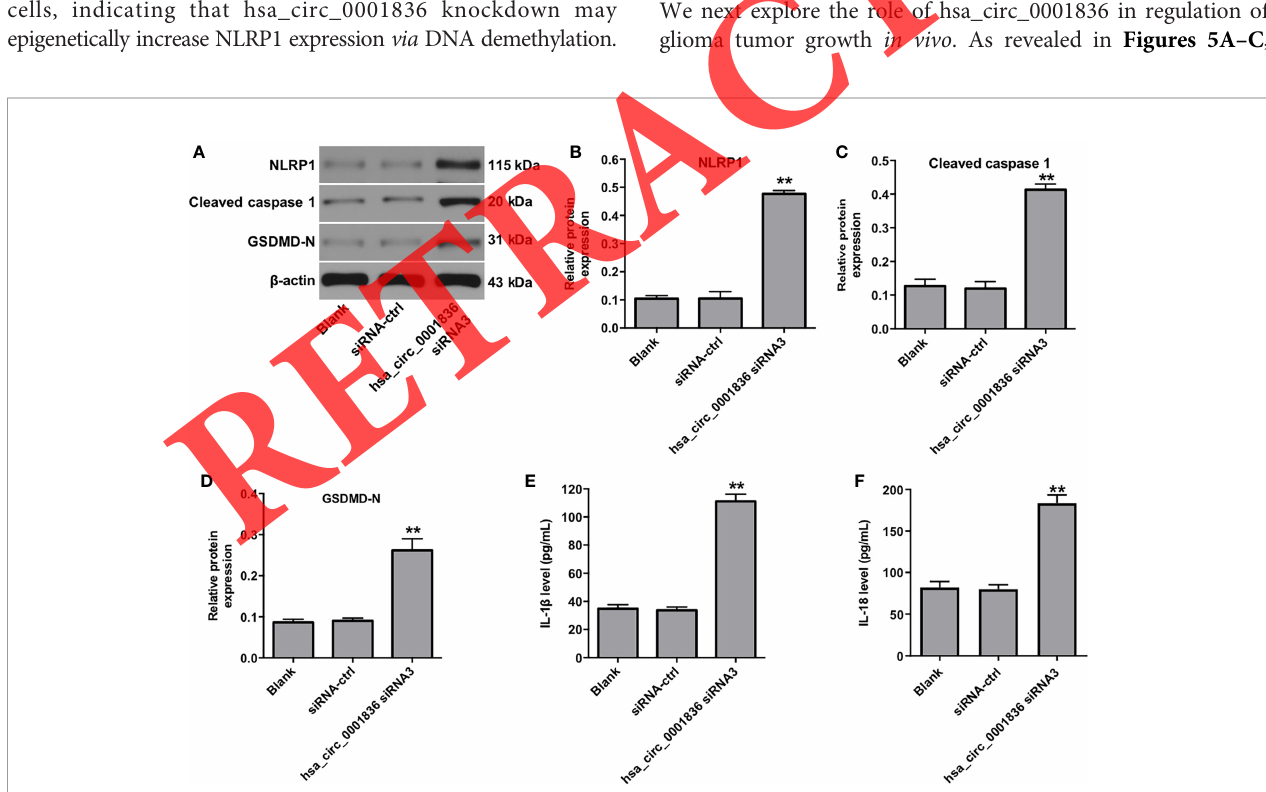
FIGURE 3 | Downregulation of hsa_circ_0001836 induced pyroptosis in glioma cells via activation of NLRP1-GSDMD signaling. U251MG cells were transfected with hsa_circ_0001836 siRNA3 for 72 h. (A – D) Western blot analysis of NLRP1, cleaved caspase 1, GSDMD-N levels in U251MG cells. The relative expressions of NLRP1, cleaved caspase 1, GSDMD-N in U251MG cells normalized to b -actin. (E) The level of IL-1 b in the culture supernatants of U251MG cells was measured using ELISA. (F) The level of IL-18 in the culture supernatants of U251MG cells was measured using ELISA. **P < 0.01 vs. siRNA-ctrl